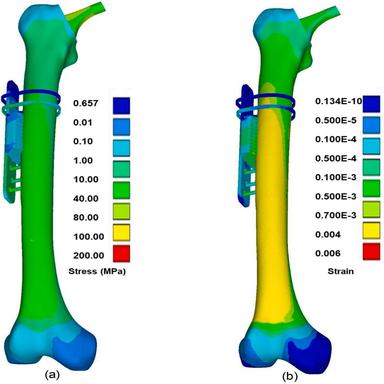
(a) The equivalent stress distribution, and (b) equivalent strain distribution at the FE model of femur bone with fracture fixation assembly, AMTD, and femoral implant for the static loading condition of 860 N.